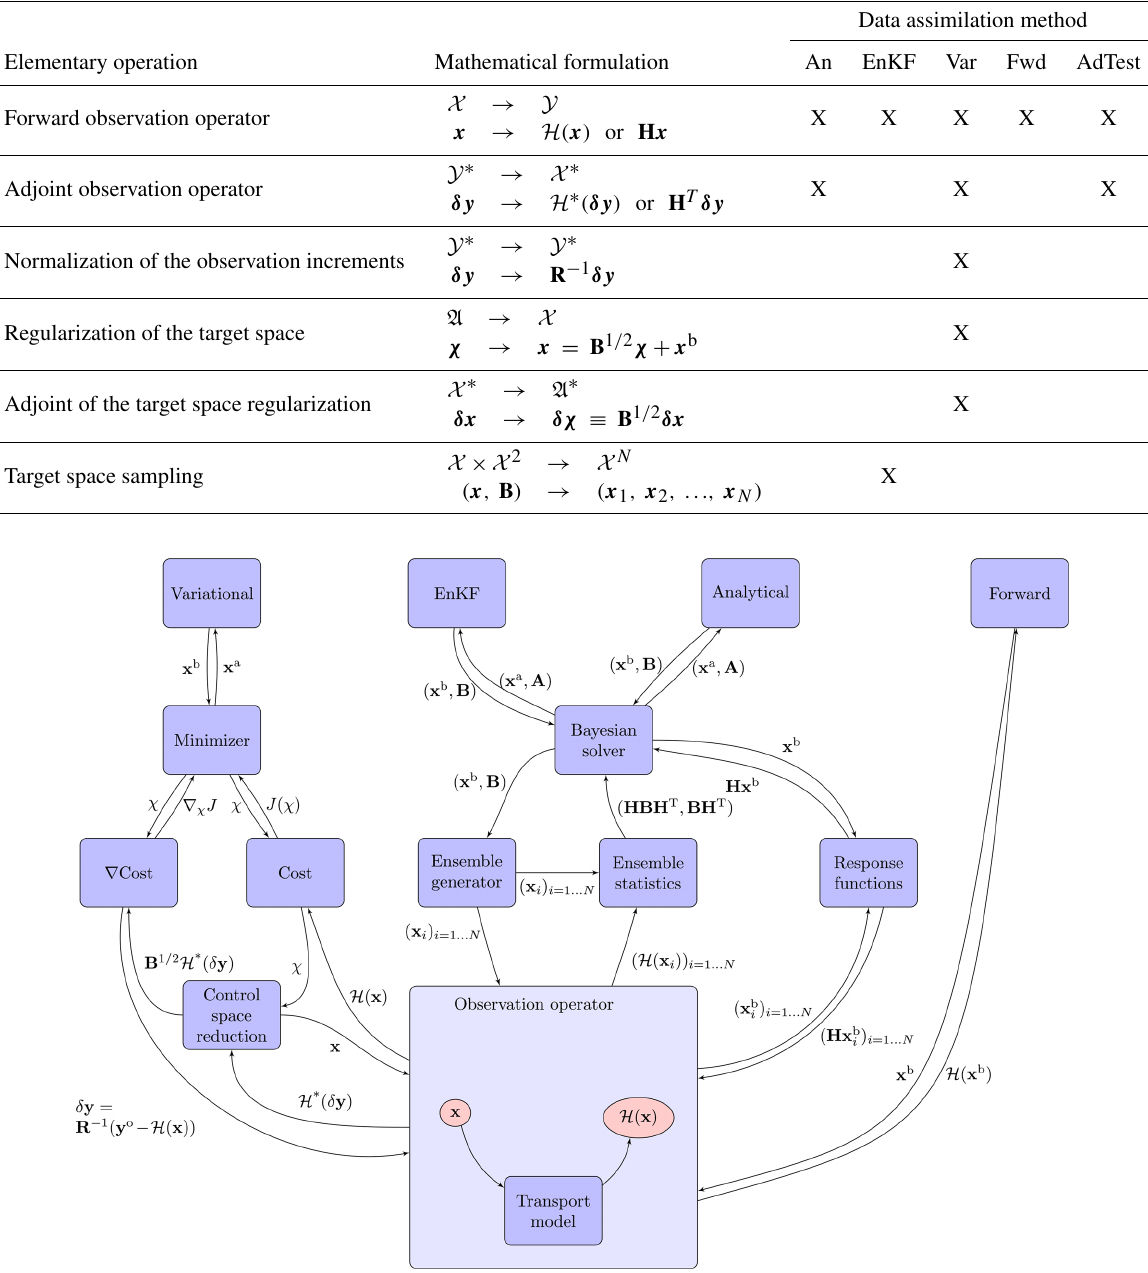
Table 1. Elementary operations required for each data assimilation method. An: analytical inversion; EnKF: ensemble Kalman filter; Var: variational; Fwd: forward simulation; AdTest: test of the adjoint. We note X and Y the target and observation spaces respectively, A the regularization space in the minimization algorithm of variational inversions; the ( · ) ∗ symbol depicts the adjoint of corresponding spaces.